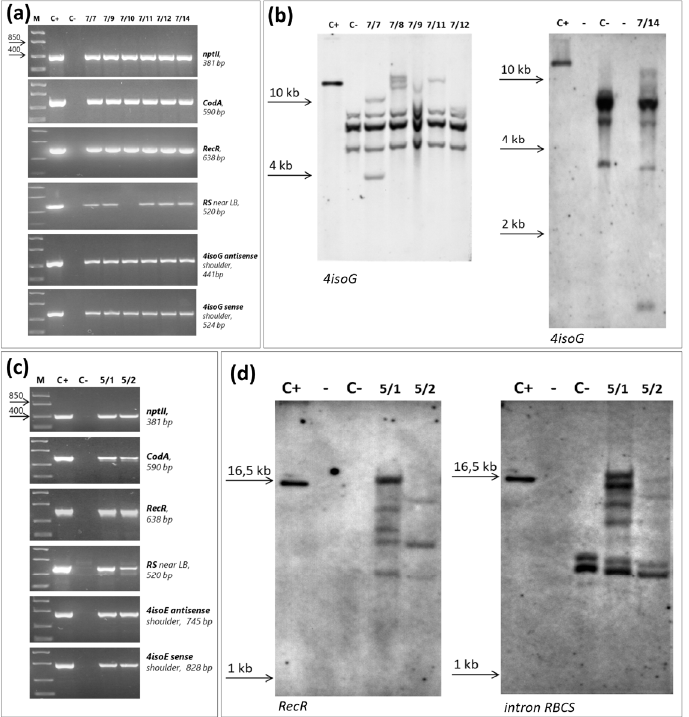
Figure 3. Analysis of rootstock lines 146-2 selected on kanamycin after agrobacterium transformation with vector pMF-R6-iso4G ( a , b ) and vector pMF-R6-iso4E ( c , d ) by PCR and Southern hybridization. ( a , c ) PCR analysis; m- molecular size marker (850, 400 base pairs of DNA); C+—positive control (pDNA); C − —negative control (gDNA of non-transformed plant of 146-2 rootstock); 7/7, 7/9, 7/10, 7/11, 7/12,7/14 and 5/1, 5/2—numbers of analyzed lines; nptII , CodA , RecR , RS, 4isoG , 4isoE — Southern blot analysis of transgenic rootstock lines; 4isoG The hybridization result of the probe to eIF(iso)4G gene followed by digesting the DNA with Xba I; RecR the hybridization result of the probe